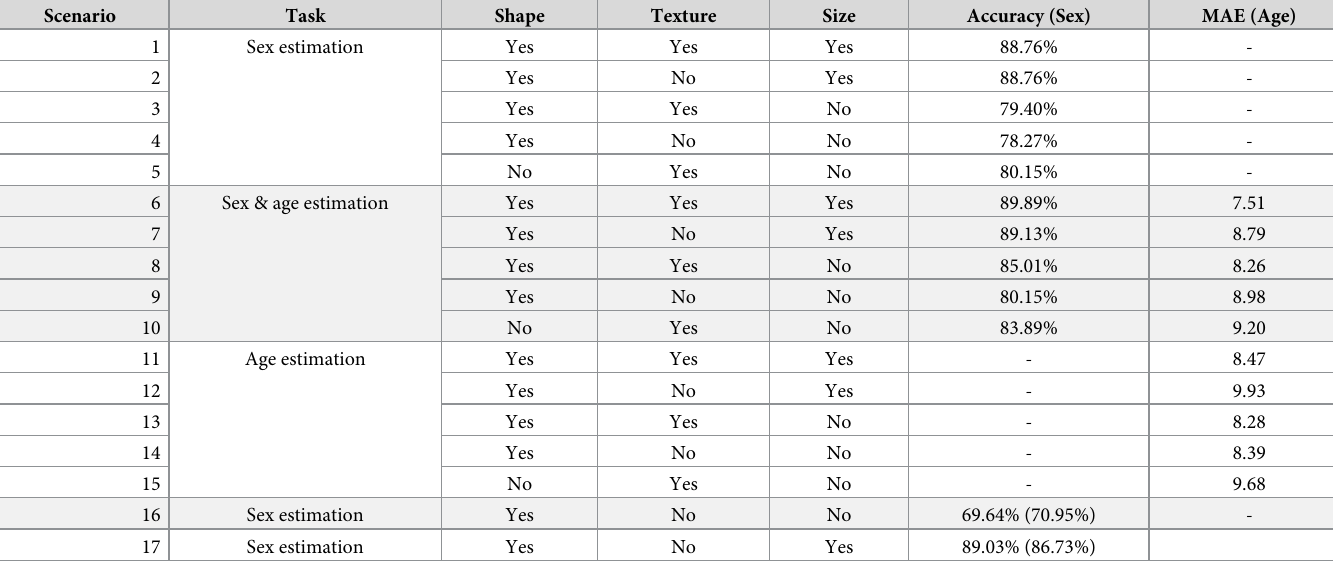
Table 2. Comparison of machine learning model accuracy (ResNet101) with different combinations of analysis using the Walker-Data.